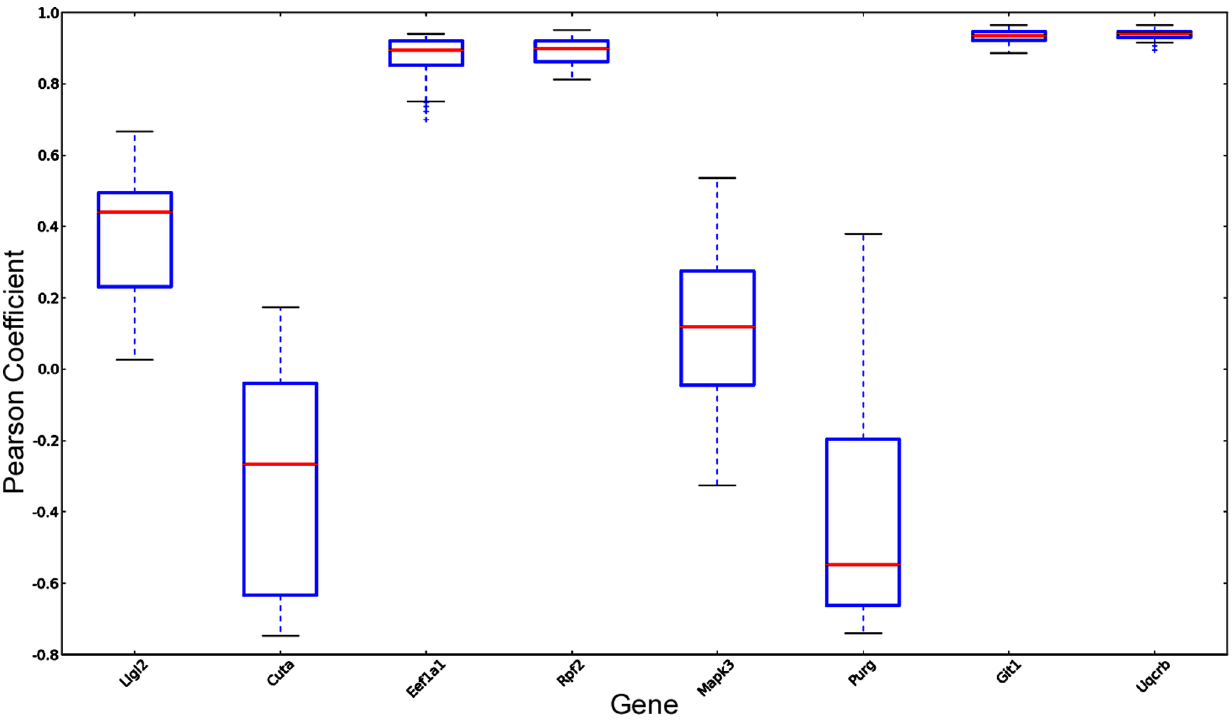
Figure 3. Boxplot of the correlation values of the feature vectors obtained from 6 slices of 8 randomly selected genes, as compared to the prototype vector. Note the very stable behavior of genes characterized by a high Pearson coefficient.